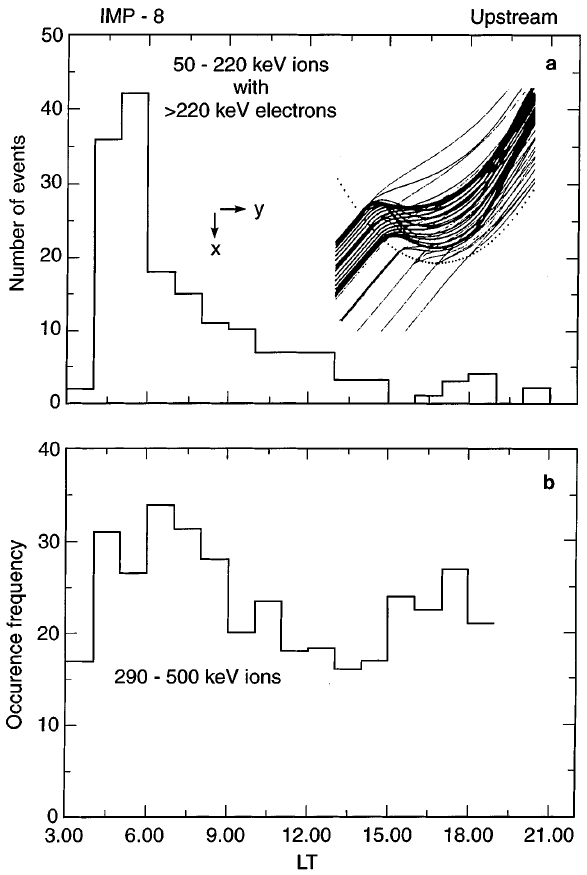
Fig. 2a, b. Spatial distribution of magnetospheric upstream ion events. The statistic a is consistent with nearly scatter free motion of (cid:24) 50 keV ions within the magnetosheath and final leakage preferentially at early local times (the inset was adapted from Fig. 1c of Luhmann et al ., 1984). High-energy ions probably escape from a broader region of the bow shock